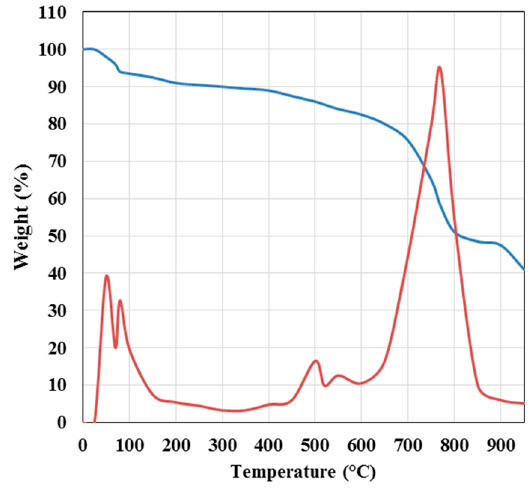
Figure 2. TG (Blue line) and DTG (Red line) of boehmite.